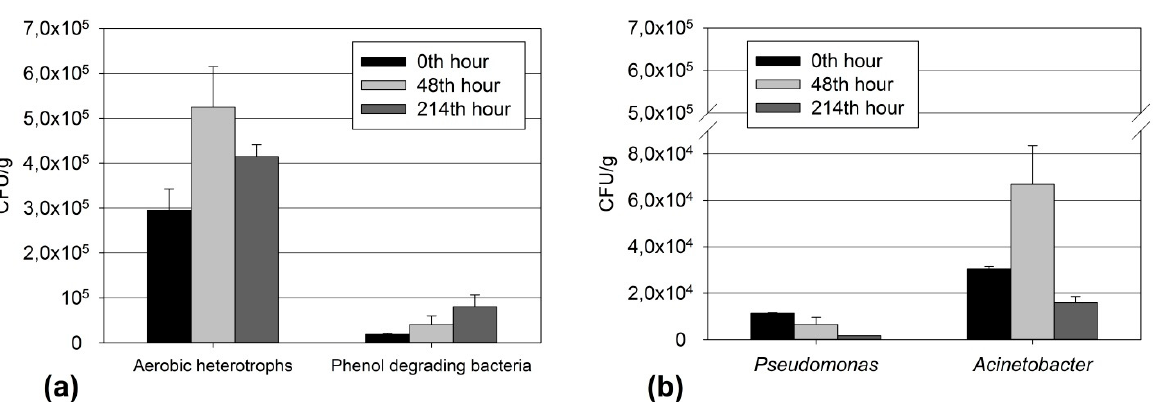
Figure 6. Quantities of: ( a ) aerobic heterotrophic bacteria and phenol ‐ degrading bacteria in the var ‐ iant without added ND; ( b ) culturable bacteria of the genus Pseudomonas and the genus Acinetobacter in the variant with added ND.